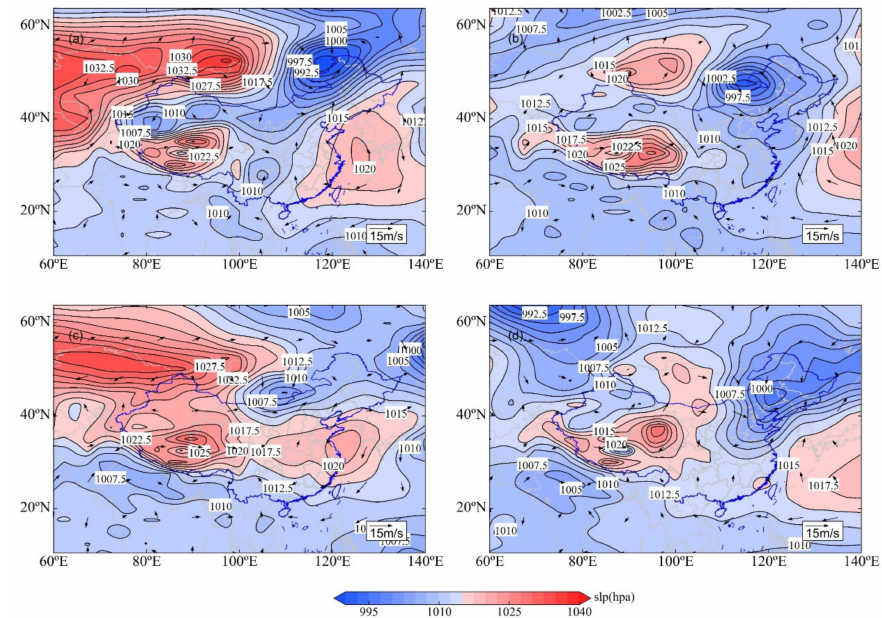
Figure 10. Distribution of the SLP field and 10 m wind field during four SDS events (( a ) 13–18 March, ( b ) 27 March–1 April, ( c ) 14–16 April, and ( d ) 6 May–8 May) in spring